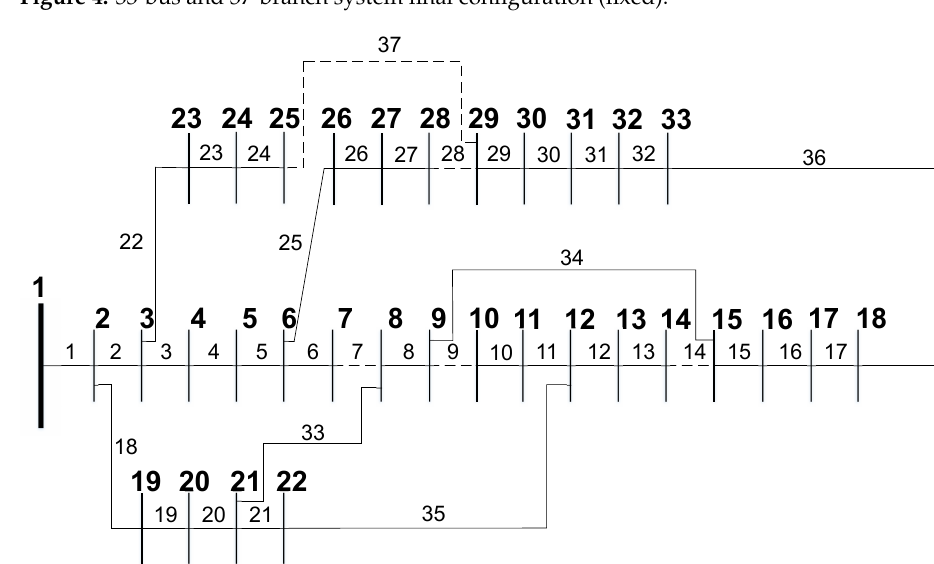
Figure 5. 33-bus and 37-branch system final configuration